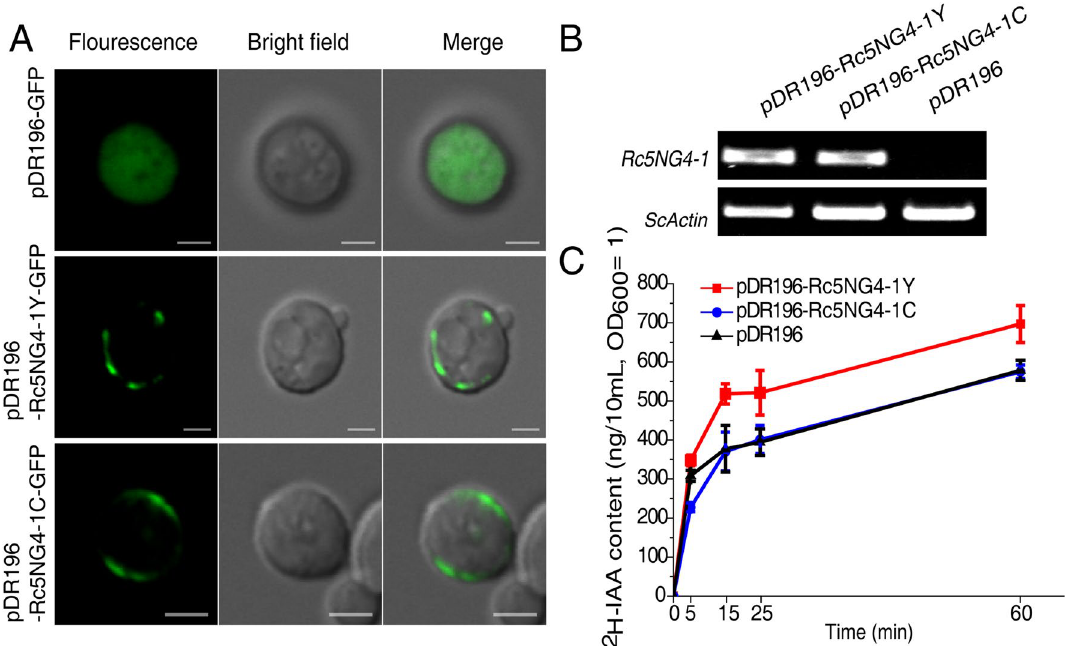
Figure 6. Examination of IAA uptake based on heterologously transformed yeast. ( A ) Rc5NG4-1Y- or Rc5NG4- 1C -fused GFP were expressed in yeast cell and fluorescence observed by confocal microscopy. Scale bar = 2 μm. ( B ) Rc5NG4-1Y and Rc5NG4-1C expression in Rc5NG4-1Y transformed yeast, Rc5NG4-1C transformed yeast and empty vector pDR196 transformed yeast detected by RT-PCR. The upper group and lower group of blots were cropped from different part of same gels, and full-length blots are presented in Figure S4. ( C ) 2 H-IAA uptake of the different transformed yeast strains. The values are means ± SD of three replications (transformations carried out once for each and then grow in triplicate).